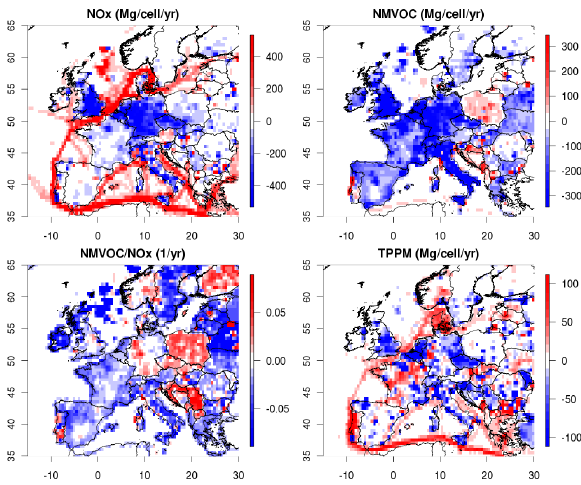
Figure 3 : Map of EMEP expert emissions trends (linear least square fit of annual totals) over 1998-2007 for NOx, NMVOC, NMVOC/NOx and total primary PM (TPPM). Units Fig. 3. Map of EMEP expert emissions trends (linear least are Mg/yr except for NMVOC/NOx (yr -1 ). square fit of annual totals) over 1998–2007 for NO x , NMVOC, NMVOC/NO x and total primary PM (TPPM). Units are Mg/yr ex- cept for NMVOC/NO x (yr − 1 )